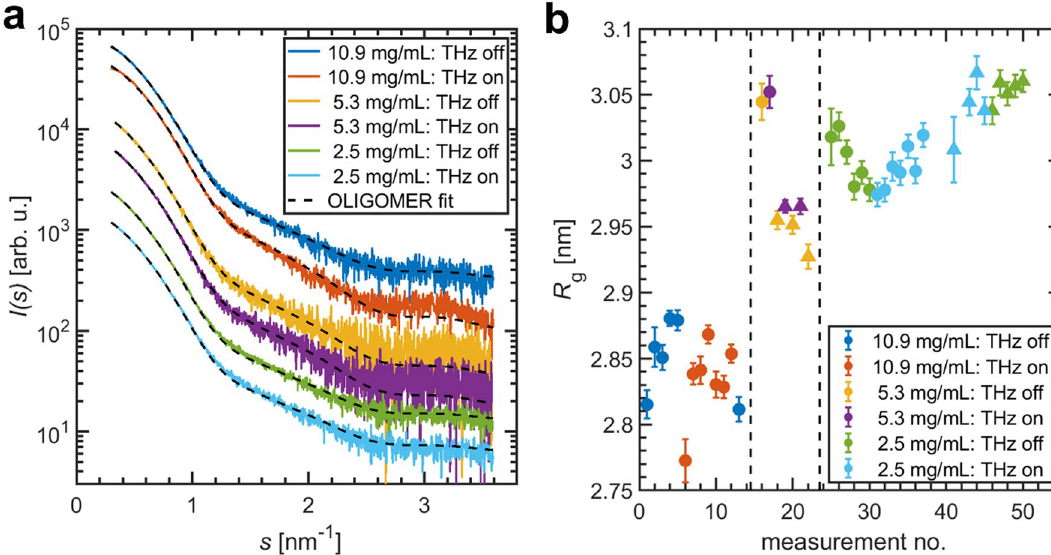
Figure 3. THz-SAXS data for BSA solutions of different concentrations exposed to an average nominal power density of 0.8 mW/cm 2 (THz source II). ( a ) SAXS profiles and OLIGOMER fits. Data for c = 5.3 mg/mL were collected in different experimental sessions. The displayed curves are shifted along the logarithmic axis. ( b ) Radius of gyration for different repeated data collections. Different symbols mark different sample